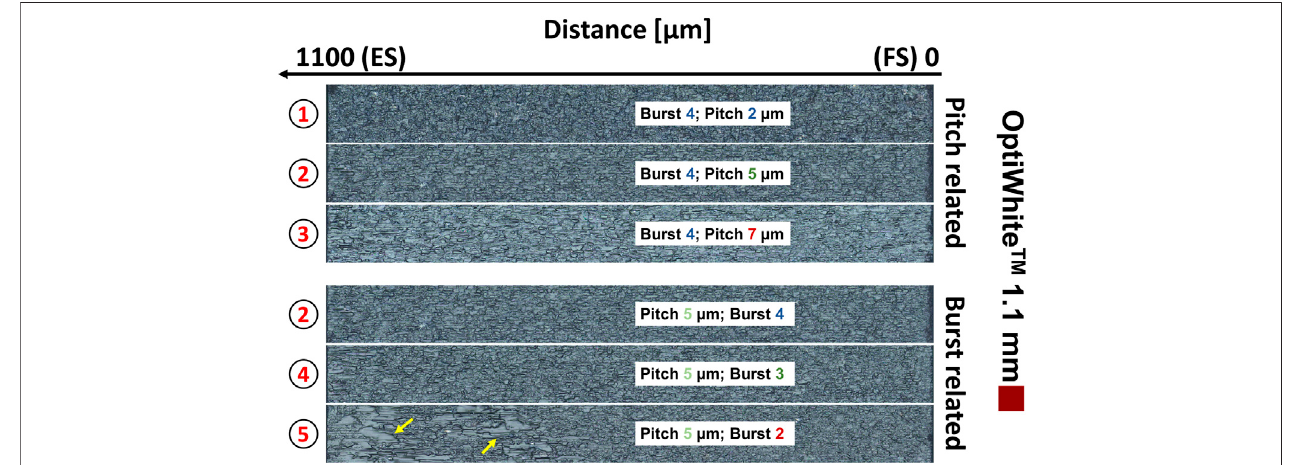
FIGURE 5 | Optical cross section images of the cut edge of OptiWhite ™ obtained with LSM. Entry-Side is located at the left (1,100 µm) and Focus-Side is at the right (0 µm). The top three images (numeration at the left) show the cross section in relation to the Pitch and on the bottom the corresponding Burst series is shown.